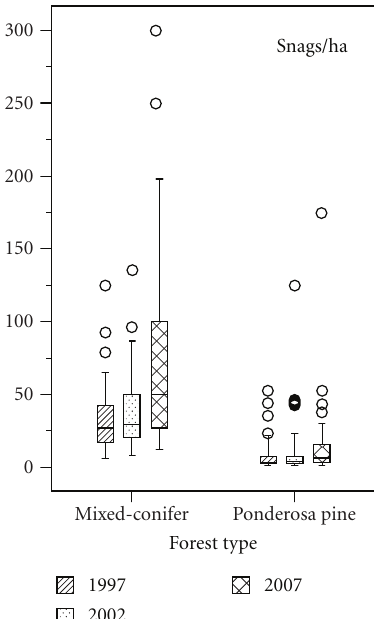
Figure 2: Trends in density (snags/ha) of snags in northern Arizona mixed-conifer and ponderosa pine forest, 1997 to 2007. Boxes indicate the interquartile range (25th to 75th percentile), the line within the box indicates the median, and the external lines show the range in the data excluding outliers (circles, defined as observations more than 1.5 box lengths outside the